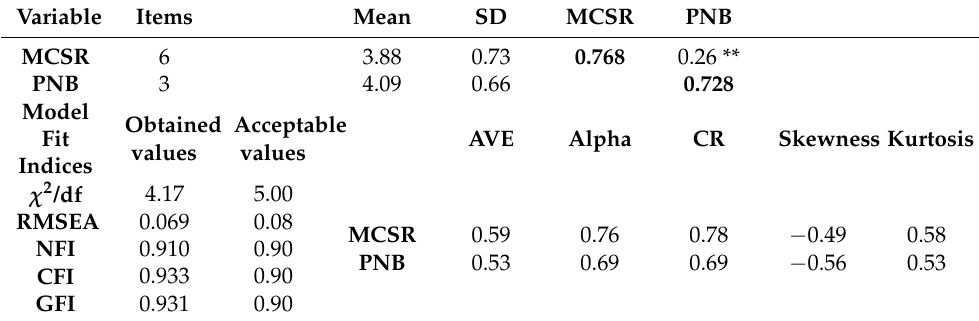
Table 3. Correlations, validities and